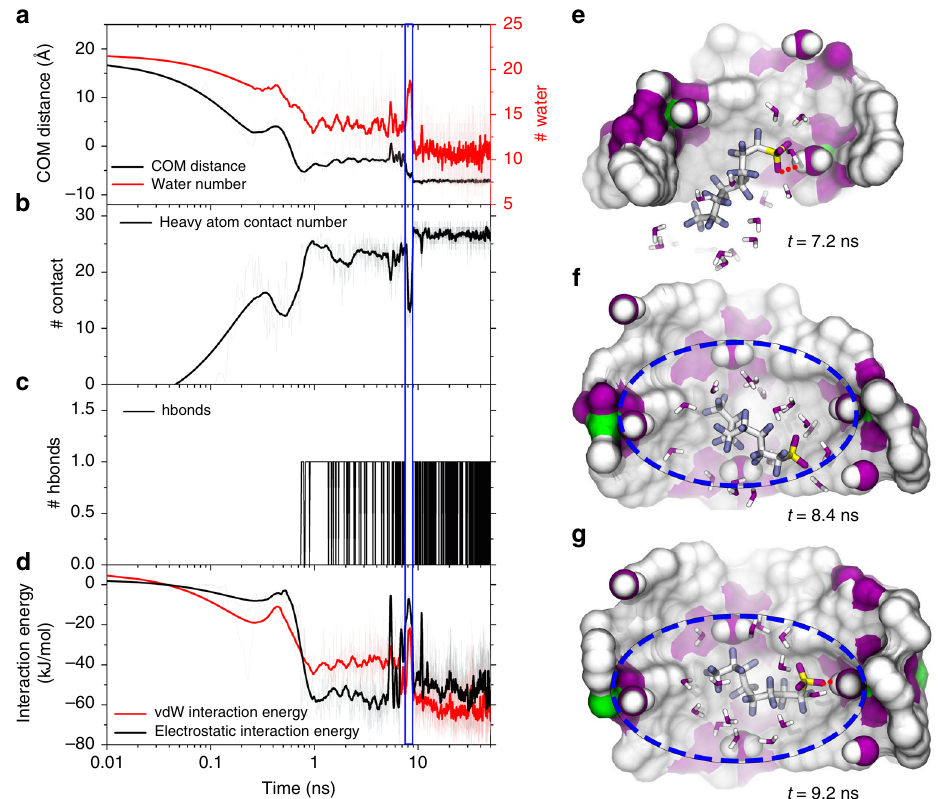
Fig. 6 The sorption dynamics of PFOS into SCU-8. A representative trajectory (run 1) to show the adsorption dynamics of PFOS into SCU-8 channel. a The distance between center of mass (COM) of PFOS and the upper surface of SCU-8 (left y axis, black curve) and the number of water in the fi rst solvation shell of PFOS (right y axis, red curve); b the heavy atom contact number between PFOS and SCU-8; c the number of hydrogen bond formed by RSO 3 − and the coordinating water in the inner wall of SCU-8 channel; d time evolution of the electrostatic and van der Waals (vdW) interaction energies between PFOS and SCU-8; e – g some critical intermediates at t = 7.2, 8.4, and 9.2 ns to show the con fi guration re-adjustment of PFOS binding to SCU-8. The color scheme is the same as Fig. 1. The red dash line stands for the hydrogen bond, and a PFOS speci fi c binding site is highlighted by the blue circle. The coordinating water is shown with vdW categories: pattern (1) the highly hydrophobic fl uorinated alkyl